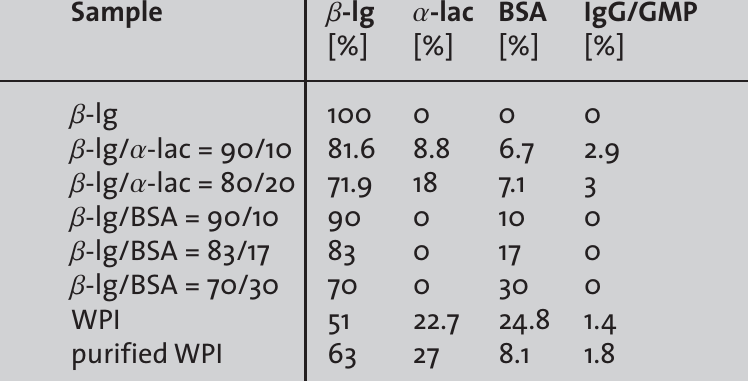
Figure 1 (left above): G’ versus strain for various total protein concentrations for mixtures with a b -lg/ a - lac ratio of 90/10. The sam- ples were heated at 2.5 wt % for 10 h at pH 2 and 80°C, subsequently cooled on ice to 0°C, after which the pH was adjusted to pH 7, the samples were diluted to the required total protein con- centration, and 0.01 M CaCl was added. The samples were allowed to gel for 3 h at 25°C before performing the strain sweep. Figure 2 (left below): G’ as a function of the total protein concentration in the samples. The samples were heated at 2.5 wt % for 10 h at pH 2 and 80°C, subse- quently cooled on ice to 0°C, after which the pH was adjusted to pH 7, the sam- ples were diluted to the required total protein con- centration, and 0.01 M CaCl was added. The samples were allowed to gel for 3 h at 25°C before performing the strain sweep. The G’ val- ues are the values from the linear regime of the strain sweep curves. a) Graph for samples with varying b - lg/ a -lac ratios: b -lg ( Á ), b - lg/ a -lac = 90/10 ( (cid:3) ), b -lg/ a - lac = 80/20 ( (cid:4) ). b) Graph for samples with varying b - lg/BSA ratios: b -lg ( Á ); b - lg/BSA = 90/10 ( Ï ), b -lg/BSA = 83/17 ( Ï ), b -lg/BSA = 70/30 ( Ì ). c) Graph for whey protein samples of various compositions: b -lg ( Á ), puri- fied WPI ( Û ), and WPI ( Ú ). Table 1: Composition of the whey protein samples in percent- age of the total protein con- centration, as determined with